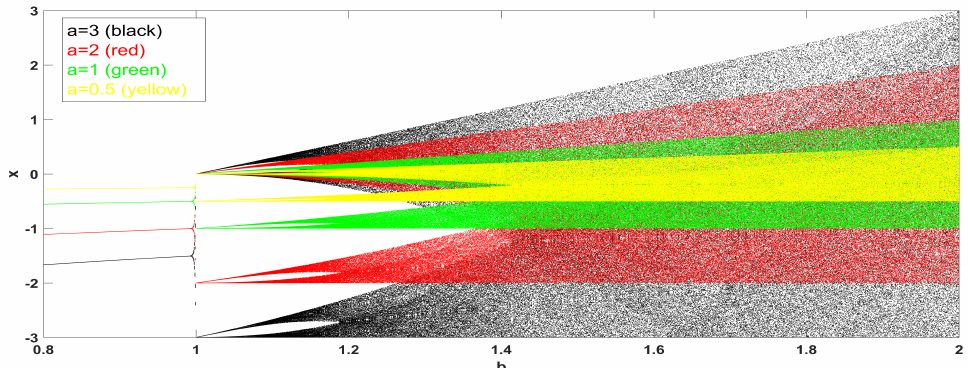
Figure 9. Bifurcation diagram with respect to parameter b for different values of a , and r =